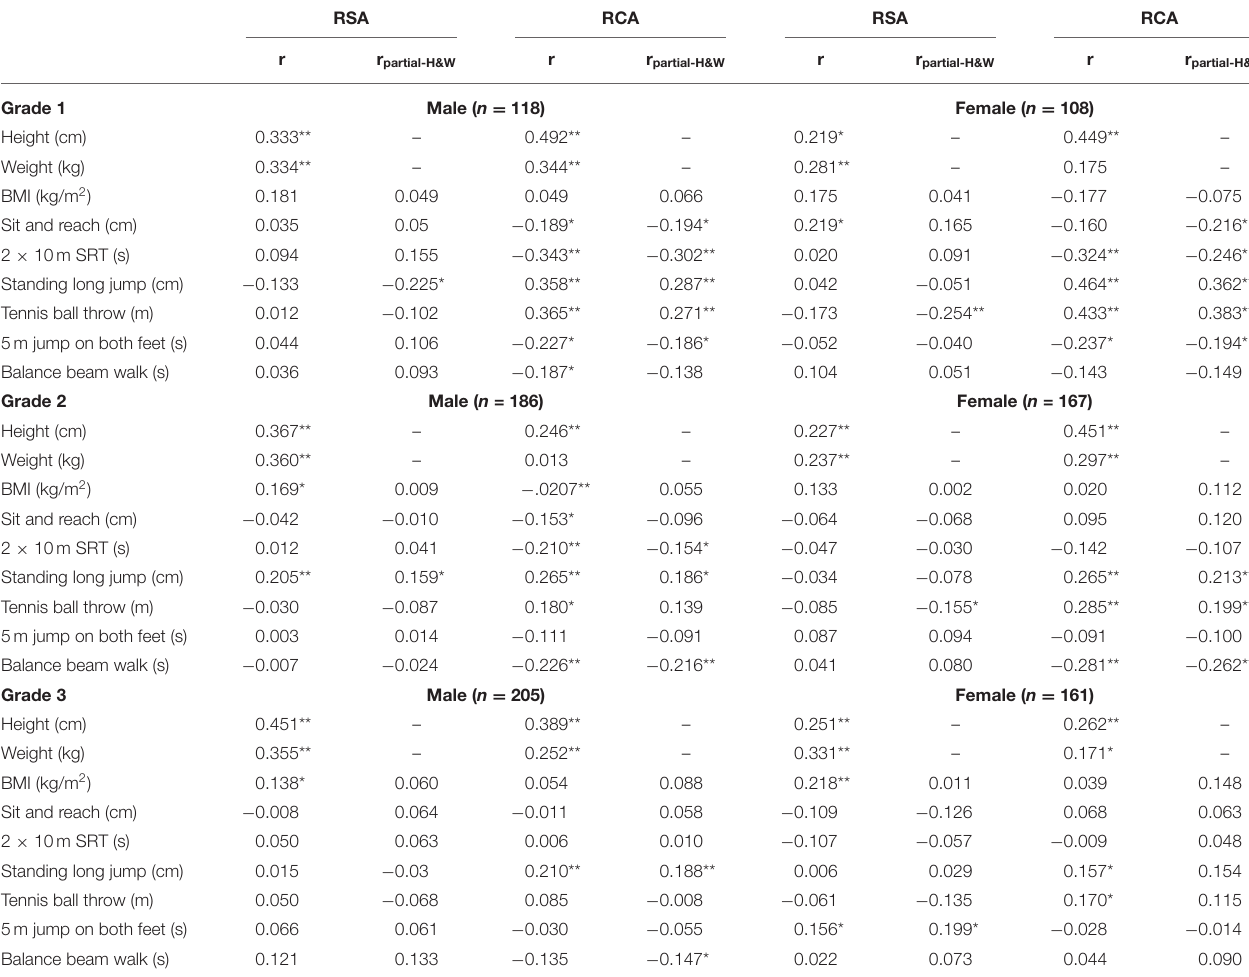
TABLE 3 | Correlations and partial correlations between relative skeletal age, relative chronological age, and body size, physical fitness in children aged 3–6 years